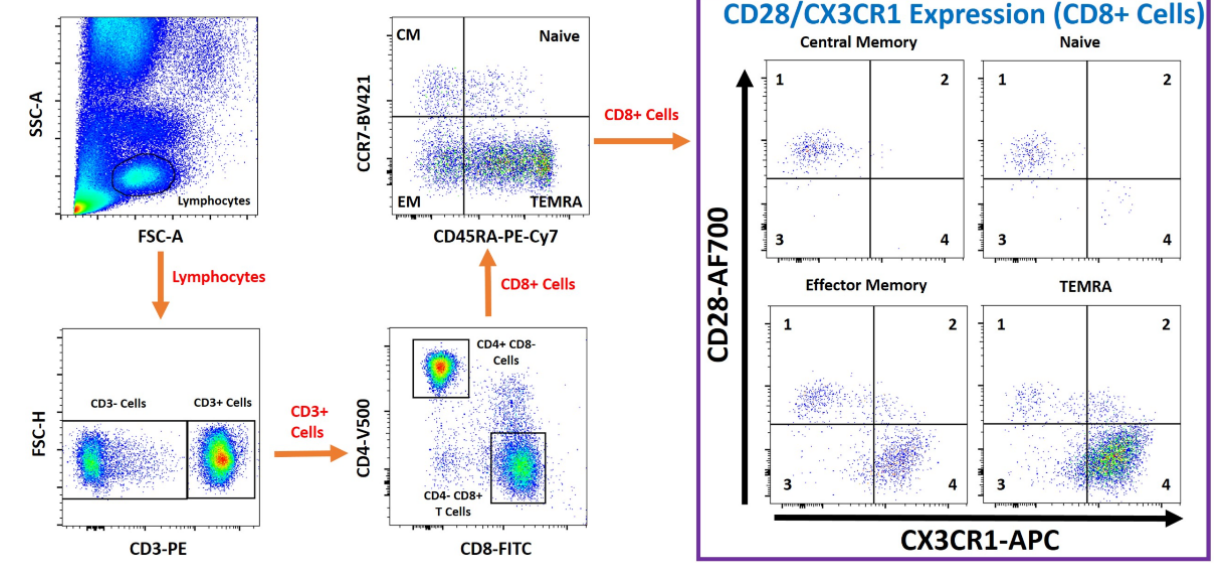
Figure 1. Example gating path for seven-color fluorescence-activated cell sorting (FACS) from ethylenediaminetetraacetic acid (EDTA) peripheral blood. AF700: Alexa Fluor 700; APC: allophycocyanin; BV421: Brillian Violet 421; CCR7: C-C chemokine receptor type 7; CD45RA: CD45 expressing exon A; CM: central memory; CX3CR1: C-X3-C motif chemokine receptor 1; EM: effector memory; FITC: fluorescein isothiocyanate; FSC: